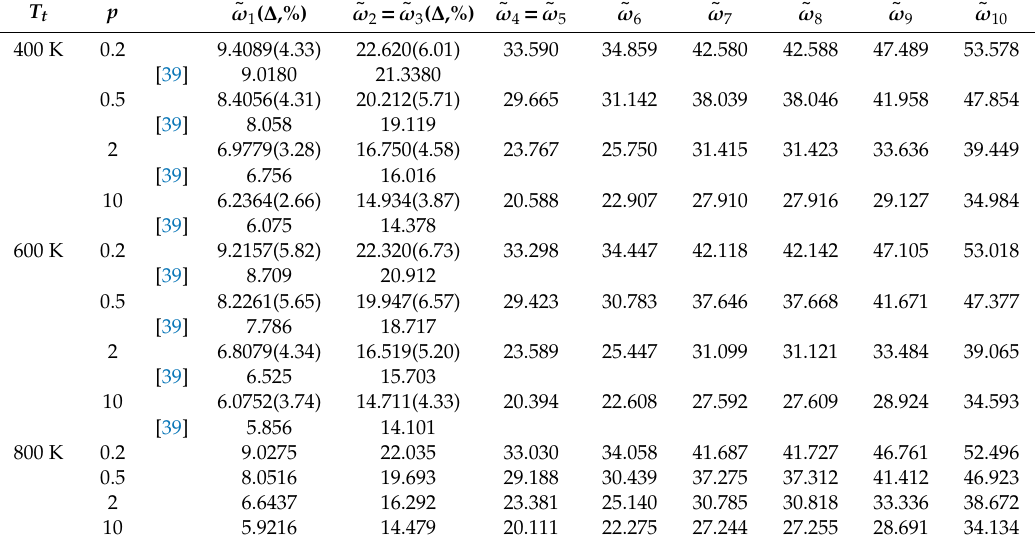
Table 7. The first ten nondimensional frequencies of SSSS SUS304 / Si 3 Ni 4 functionally graded square 1-8-1 sandwich plates thermally loaded by the nonlinear temperature rise.